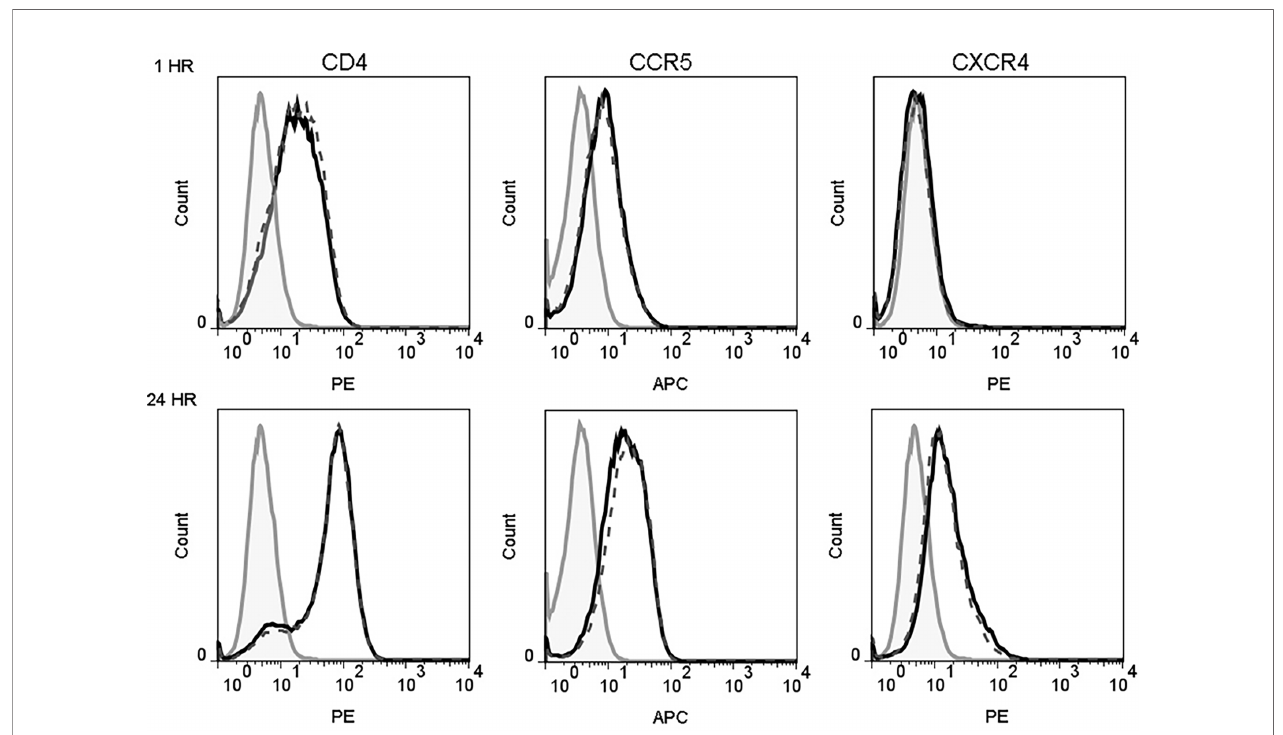
FIGURE 2 | hBD2 does not alter surface expression of HIV receptors on macrophages. MDM were cultured in the absence (black solid lines) or presence (black dotted lines) of hBD2 for different times. The surface expression of CD4, CCR5, and CXCR4 was assessed by fl ow cytometry as described in Materials and Methods . Data analyzed using FlowJo software. Left, middle, and right panels show staining of CD4, CCR5, and CXCR4, respectively. Isotype-matched control antibodies are shown in grey. The x-axis and y-axis show fl uorescence intensity and cell count, respectively. Representative experiment, n =2.